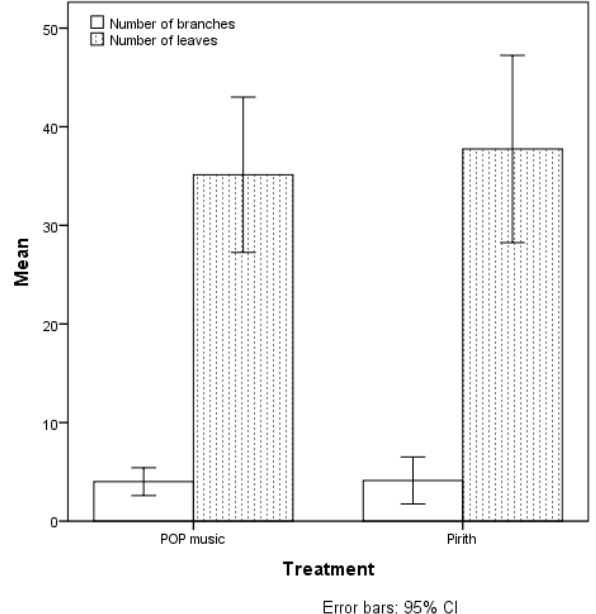
Figure 2: Variation of number of branches and number of leaves under different treatments. Chi square test values for number of plants and number of leaves were 8.8 and 9.33 and the associated p values were 0.183 and 0.591